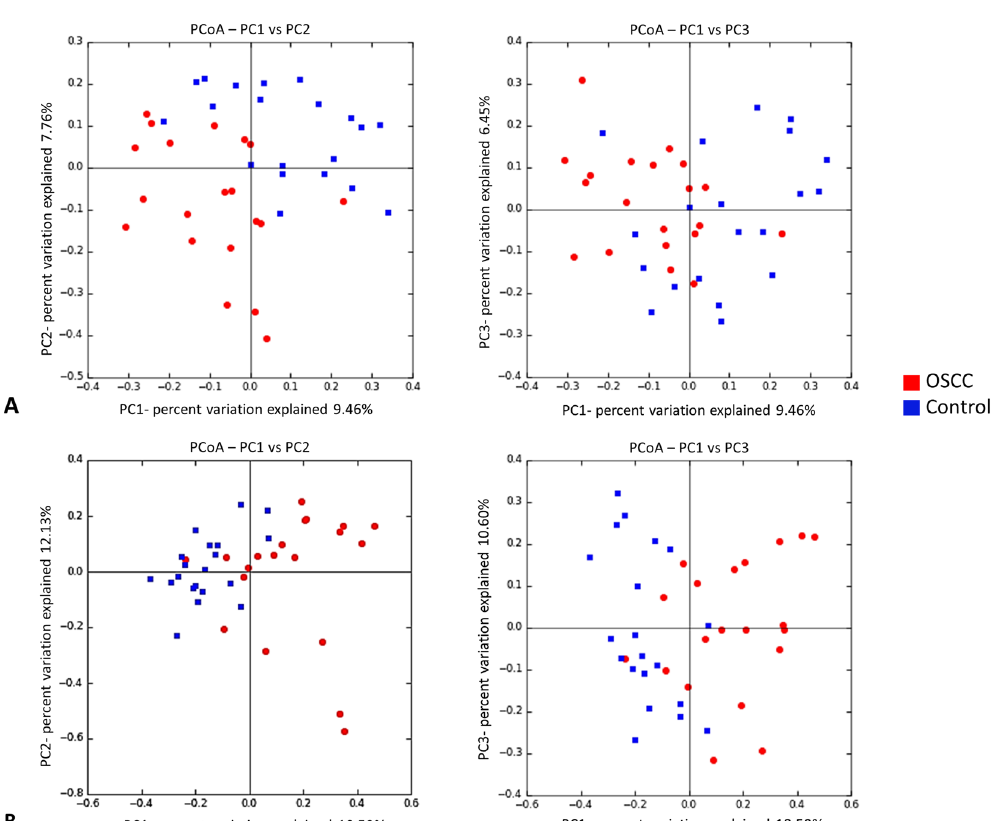
Figure 3. Principal Component Analysis. Clustering of the samples based on ( A ) binary Jaccard index (community membership) and ( B ) abundance weighted Jaccard index (community